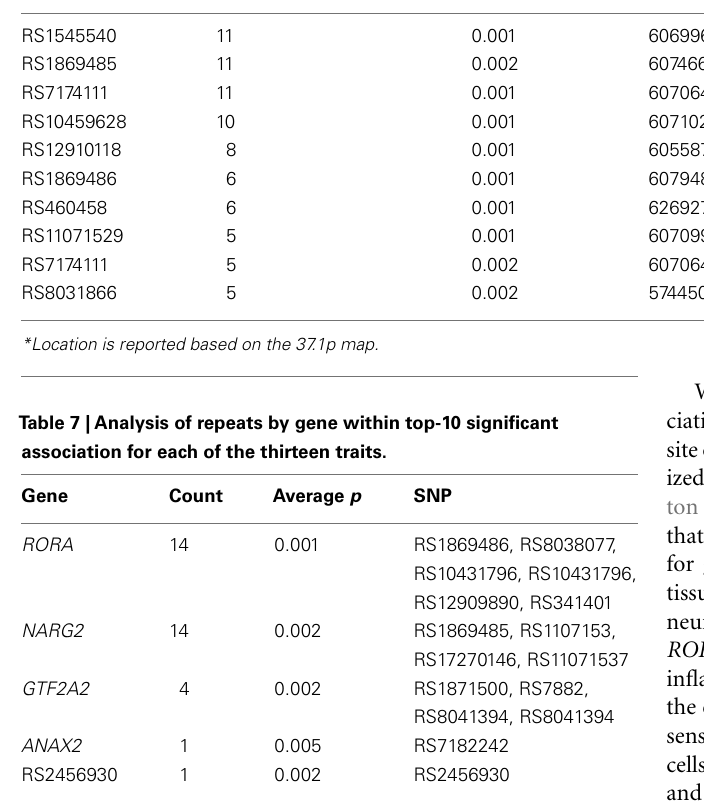
Table 6 | Frequency repeats by SNPs within N = 130 of top-10 significant associations for each of the thirteen traits.